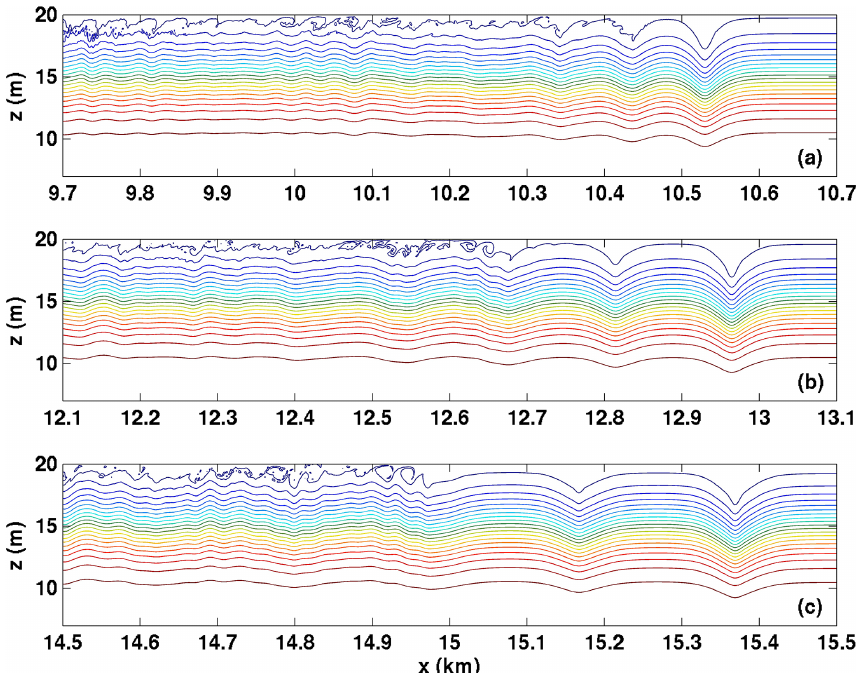
Figure 7. Density fields for wave trains propagating with the shear current for Case NO DJL 1. (a) t = 7200s, (b) t = 14400s, and (c) t =